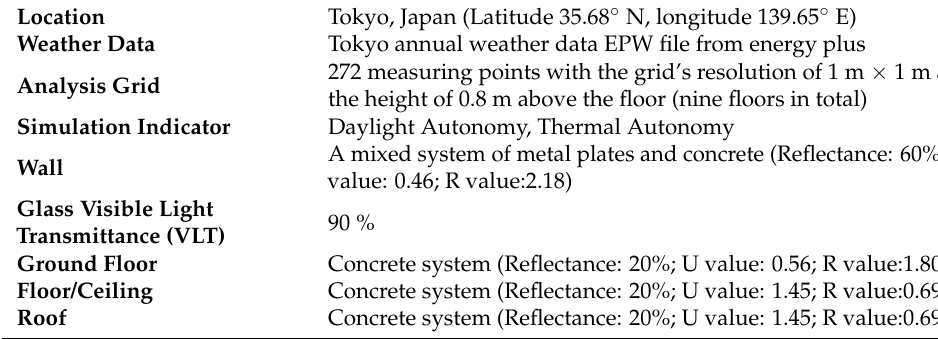
Table 1. Simulation parameters